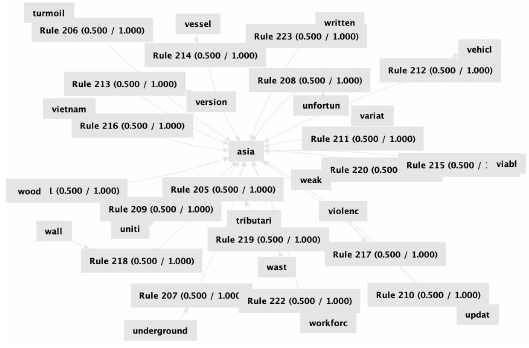
Figure 5. Visualization of Association Rules in RapidMiner